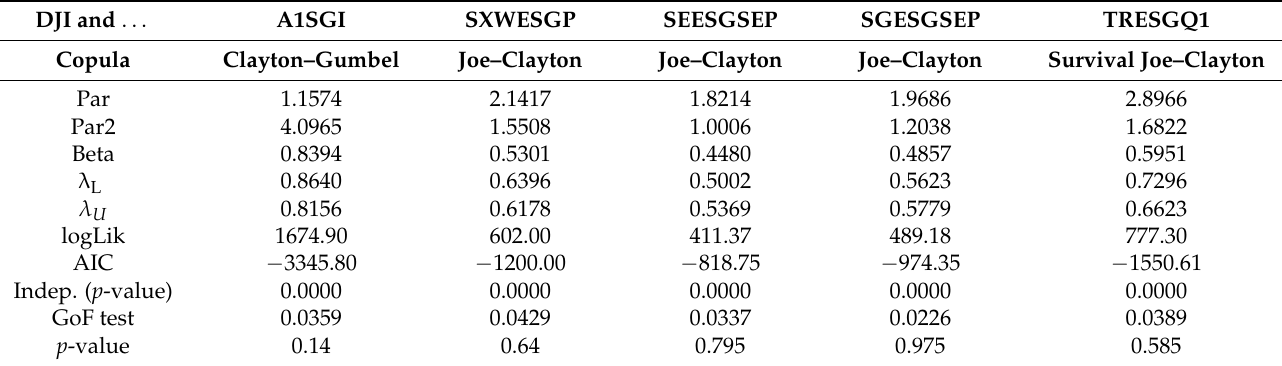
Table 6. Dependence structure for DJI and ESG indices, 2 December 2009–30 July 2014. DJI and . .